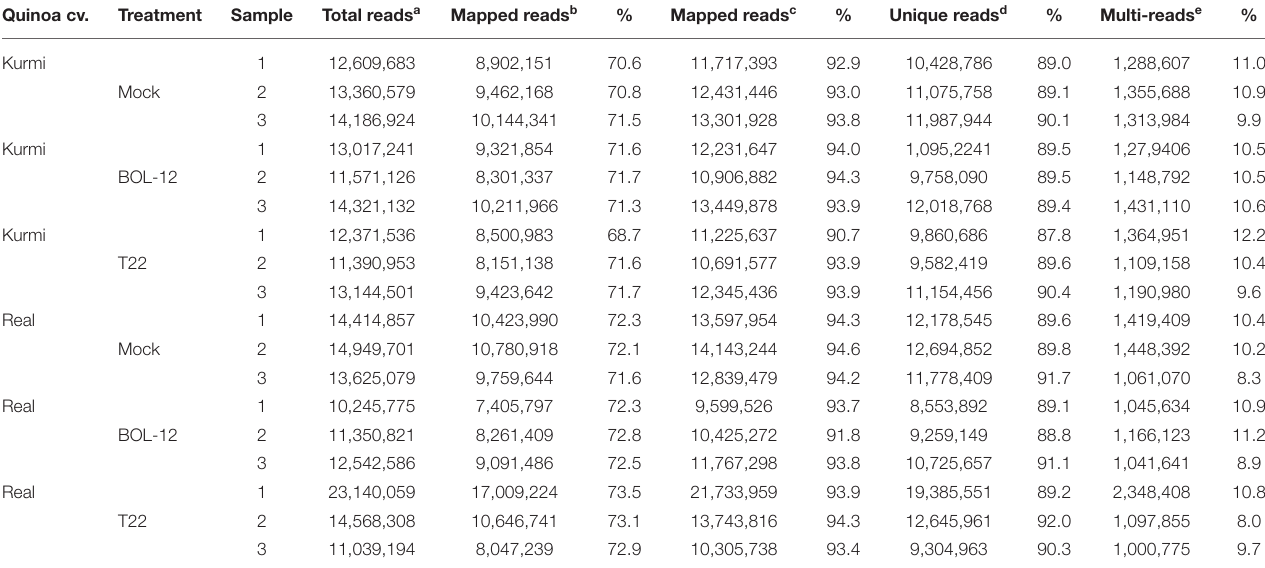
TABLE 1 | RNA-seq summary of read numbers mapped to two quinoa reference genomes. Quinoa